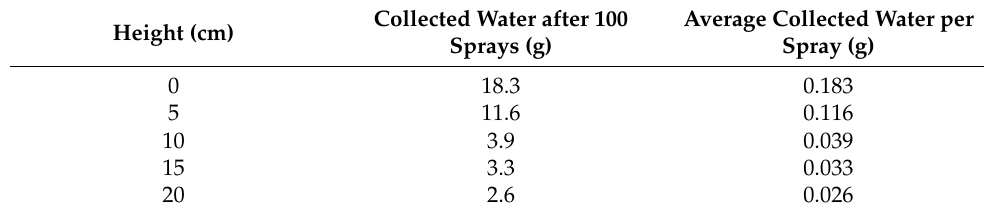
Table 1. Water mass collected in the container after spraying from progressively increased heights above the top open surface.